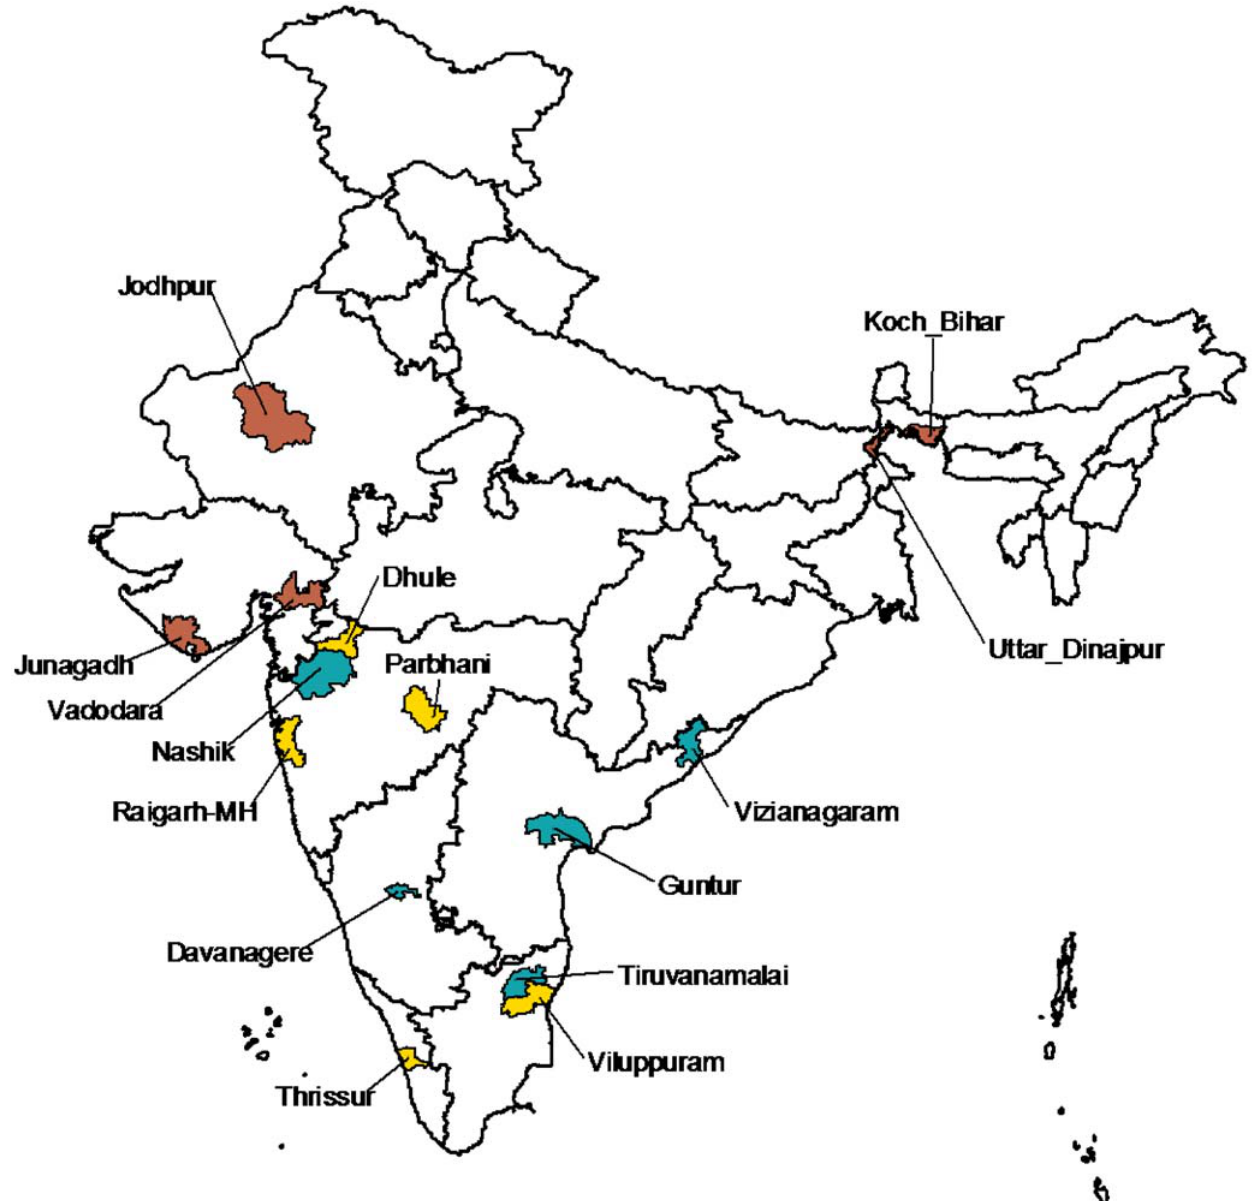
Figure 1. Districts selected for the survey . District selection stratified by mean HIV seroprevalence in antenatal clinic (ANC) surveillance sites, 2003–2005. Districts shaded blue had mean 2003–2005 ANC HIV seroprevalence 0–0.5%, yellow districts had ANC HIV seroprevalence 0.51–1.0%, and red districts had ANC HIV seroprevalence . 1.0%. The districts of Davangere, Guntur, Nasik, and Tiruvanamalai were selected in the previous years’ survey, and were purposively selected again for trend analysis.